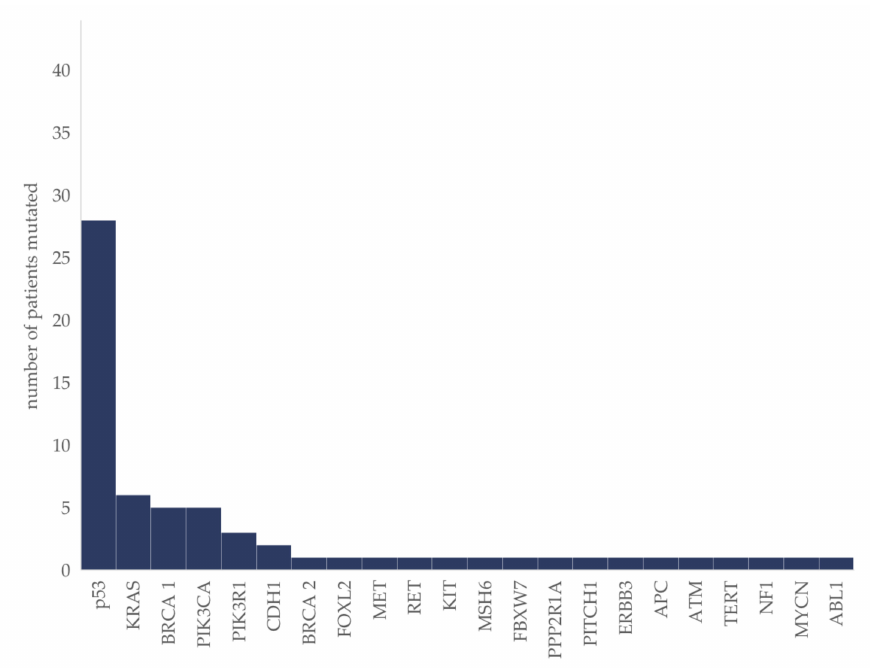
Figure 1. Molecular aberrations in ovarian cancer patients ( n = 44). The absolute number of patients in which the respective mutation was identified is